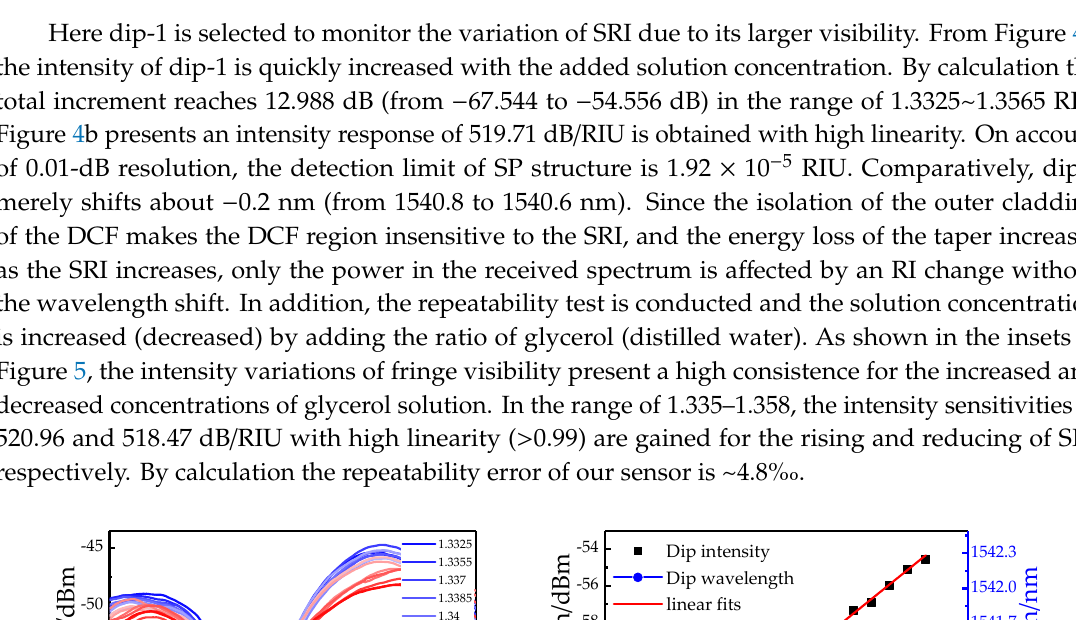
Figure 3. Experimental setup.